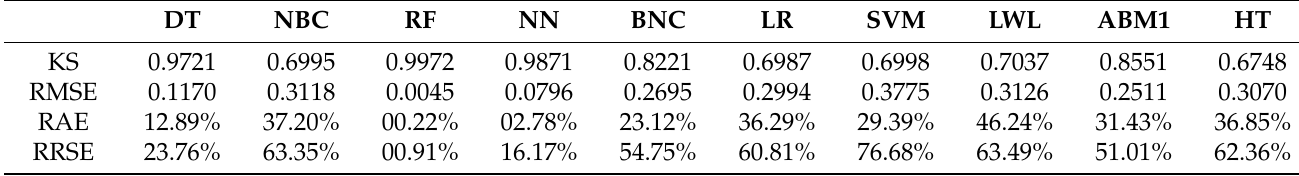
Table 4. Kappa, MAE, RMSE, RAE, and RRSE values for the machine learning algorithms.